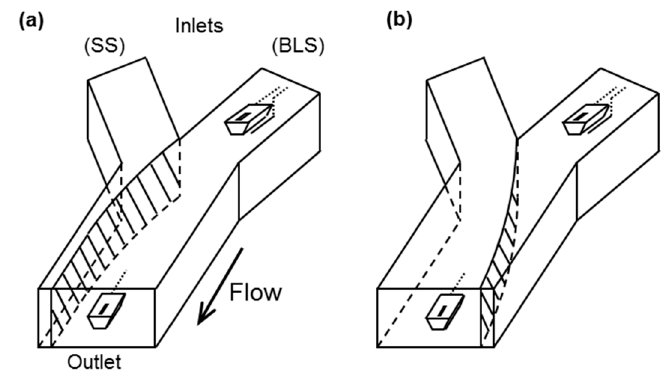
Figure 2. Measurement principle using a Y-shaped channel and pH-FET sensors. The flowing paths of the two solutions at ( a ) the initialization stage before measurement and ( b ) during measurement. The hatched region shows the area of contact between the two solutions, a region that serves as a liquid junction during measurement.